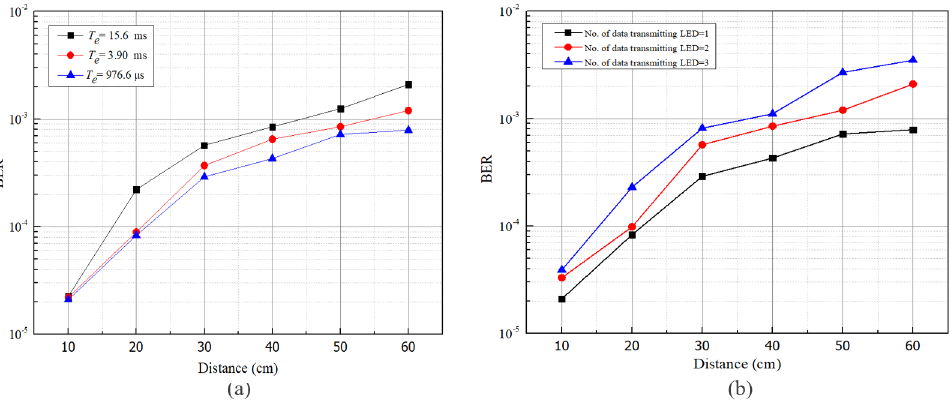
Figure 11. BER analysis by varying ( a ) exposure time ( T e ) and ( b ) no. of data transmitting LEDs.